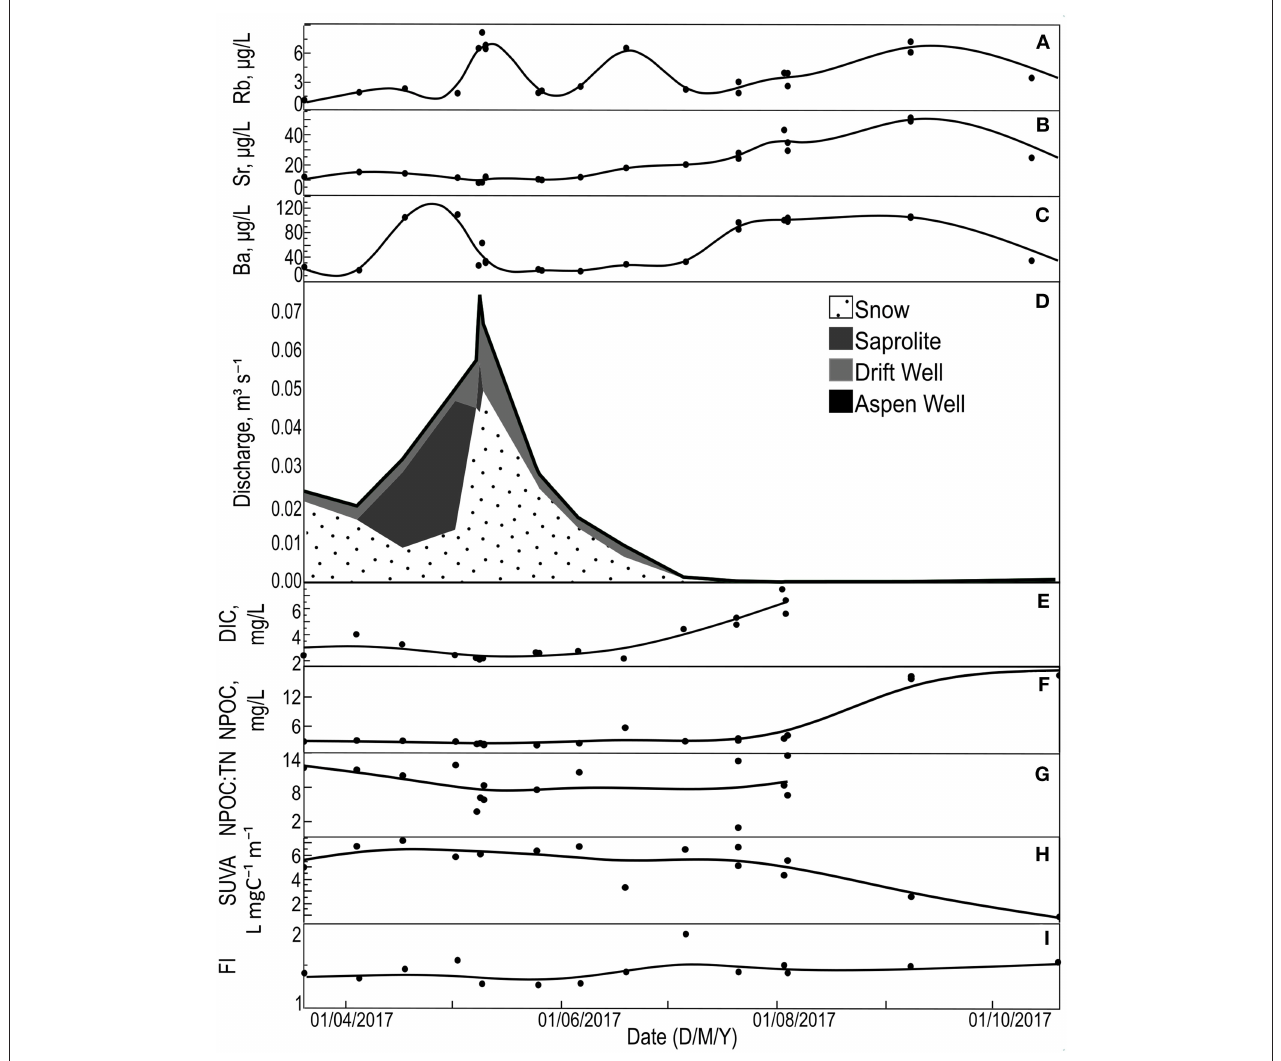
FIGURE 5 | Time series of tracers in streamwater samples (A–C) with spline fits ( λ = 0.0002). Contributions of each end-member to streamflow from March to October 2017 (D) calculated using EMMA with the above tracers. Because sampling frequency increased around peak flow, there are more abrupt changes in proportion estimates at this time. Spline fits to DIC, DOC, C:N ratio, SUVA, and FI values (E–I) in the same streamwater samples ( λ = 0.05). Samples could not be run for DIC or TN after August due to equipment